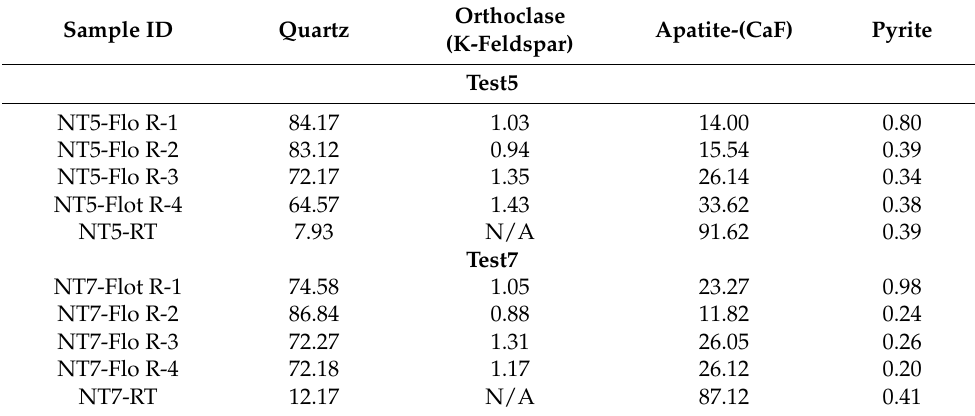
Table 3. Mineral analysis of the representative tests 5 and 7 (NT5, NT7).